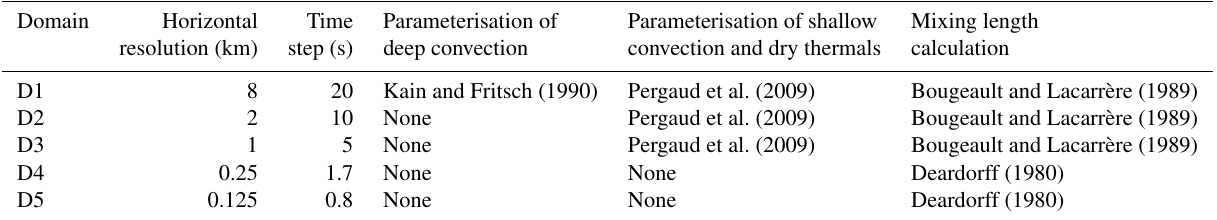
Table 1. Physical parameterisations employed for the Meso-NH simulations. Domain Horizontal Time Parameterisation of Parameterisation of shallow Mixing length resolution (km) step (s) deep convection convection and dry thermals calculation D1 8 20 Kain and Fritsch (1990) Pergaud et al. (2009) Bougeault and Lacarrère (1989) D2 2 10 None Pergaud et al. (2009) Bougeault and Lacarrère (1989) D3 None Pergaud et al. (2009) 0.25 None None D5 0.125 0.8 None None Deardorff